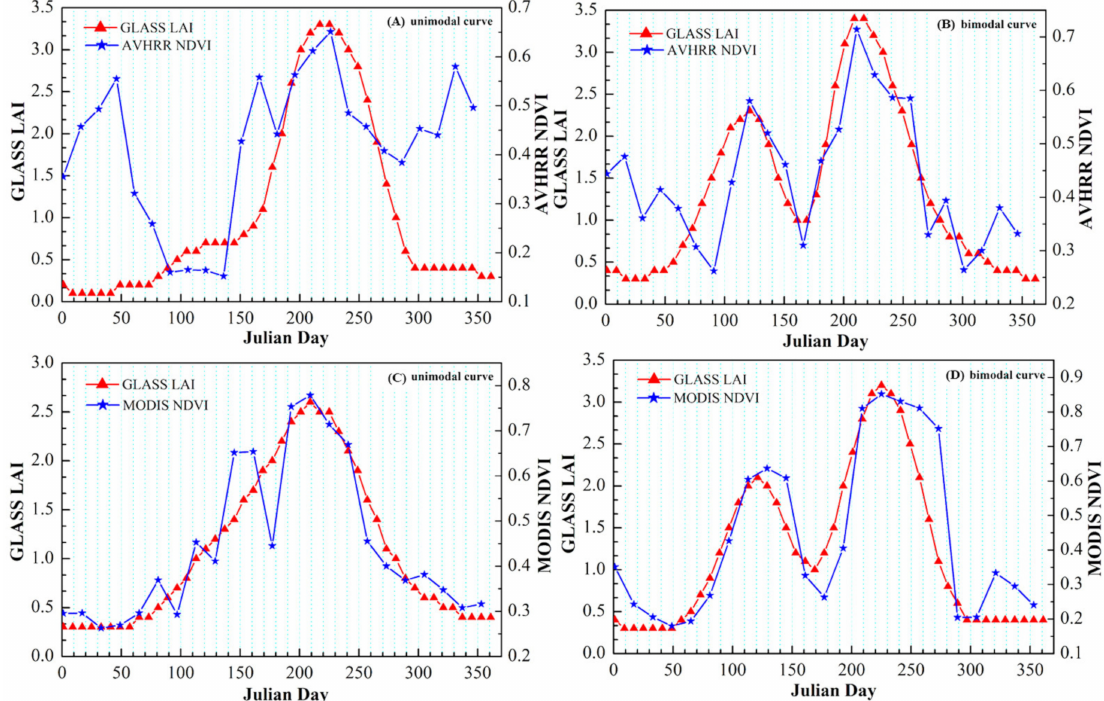
Figure 13. Comparison of GLASS LAI, AVHRR NDVI and MODIS NDVI time series curves for the NCP. ( A ) and ( B ) are the comparisons of GLASS LAI and AVHRR NDVI time series for the NCP in 1982. ( C ) and ( D ) are the comparisons of GLASS LAI and MODIS NDVI time series for the NCP in